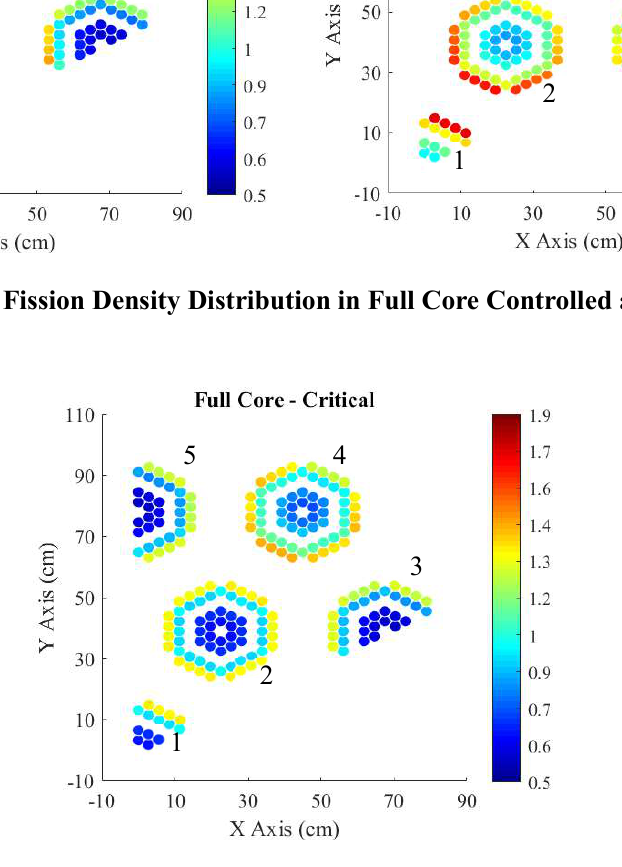
Table II. Assembly Averaged Fission Density